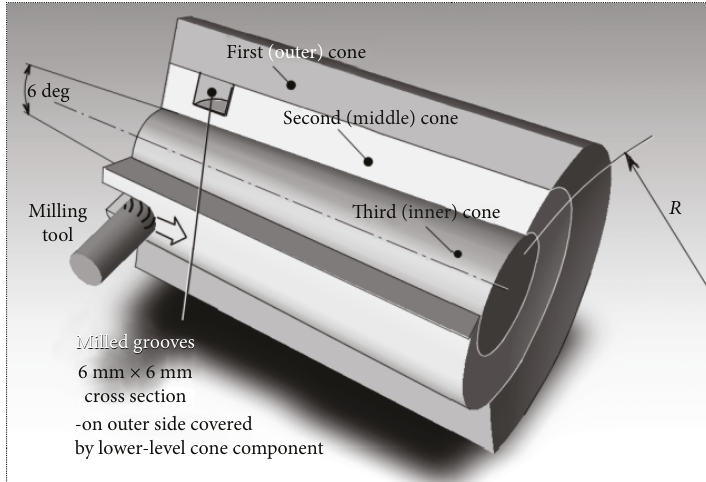
Figure 4: The basic principle of the distributor body layout. The grooves milled on the outer surface of the three 6deg cone-shaped components, nesting one into another, are used for the role of the equal-length channels. The milling tool seen at the left follows the bifurcation trajectories such as those presented in Figure